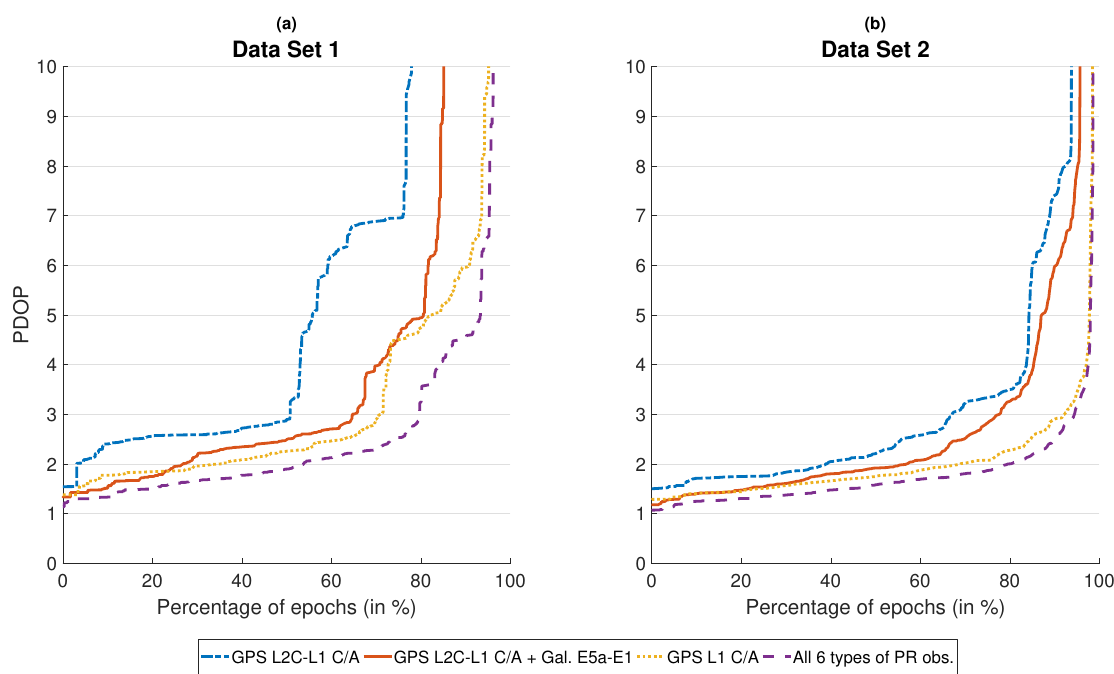
Figure 4. Percentage of GNSS measurement epochs in which PDOP was at least as good as